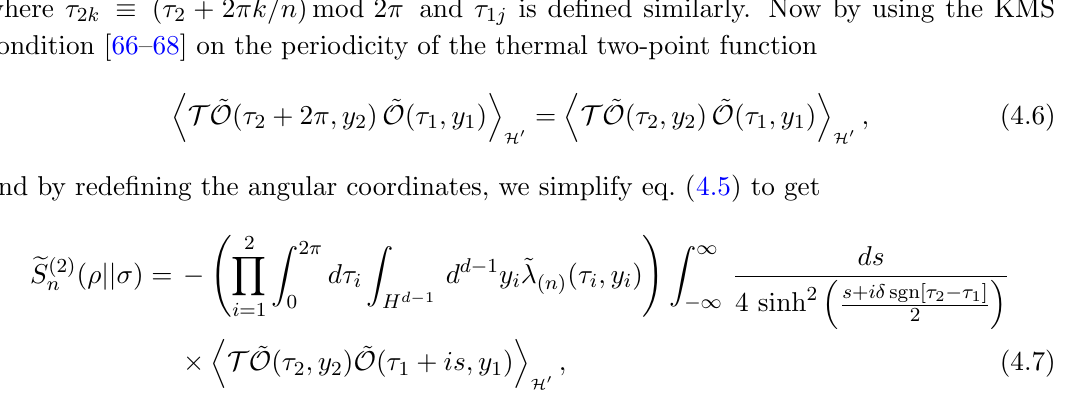
Figure 2 . A pictorial representation of the source function ~ (cid:21) ( (cid:28); y ) and the Z function ~ (cid:21) ( (cid:28); y ) where we have suppressed the y -coordinates for clarity. The functions are non- (3) zero everywhere except in the shaded regions. Both the source function ~ (cid:21) and the Z 3 -symmetric source function ~ (cid:21) are symmetric around (cid:28) = (cid:25) . Whereas the source function ~ (cid:21) is non-zero (3) only in the neighborhood of two points, the Z 3 -symmetric source function ~ (cid:21) neighborhood of six points and has a periodicity of 2 (cid:25)= 3